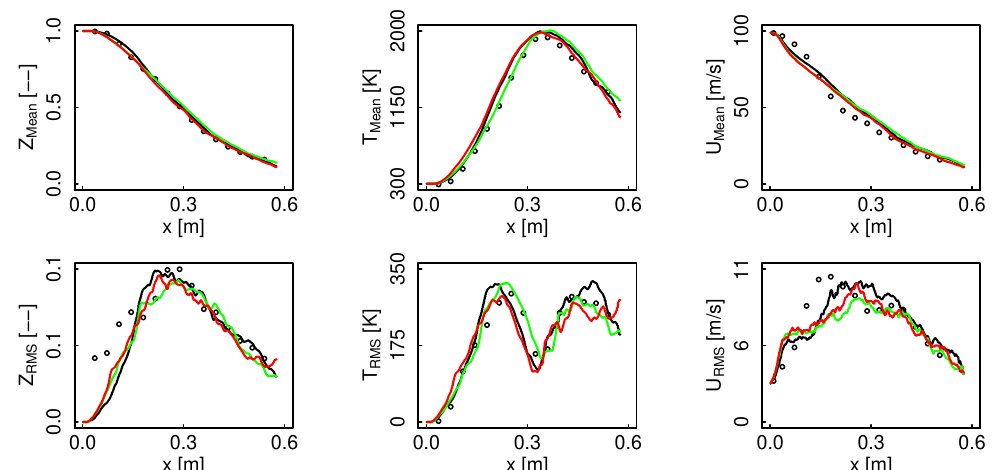
Figure 5. Flame E mixture fraction, temperature and velocity profiles along the centerline. Black color represents non-premixed FTACLES, green color premixed FTACLES, red color FPV, and circles depict the experimental data.